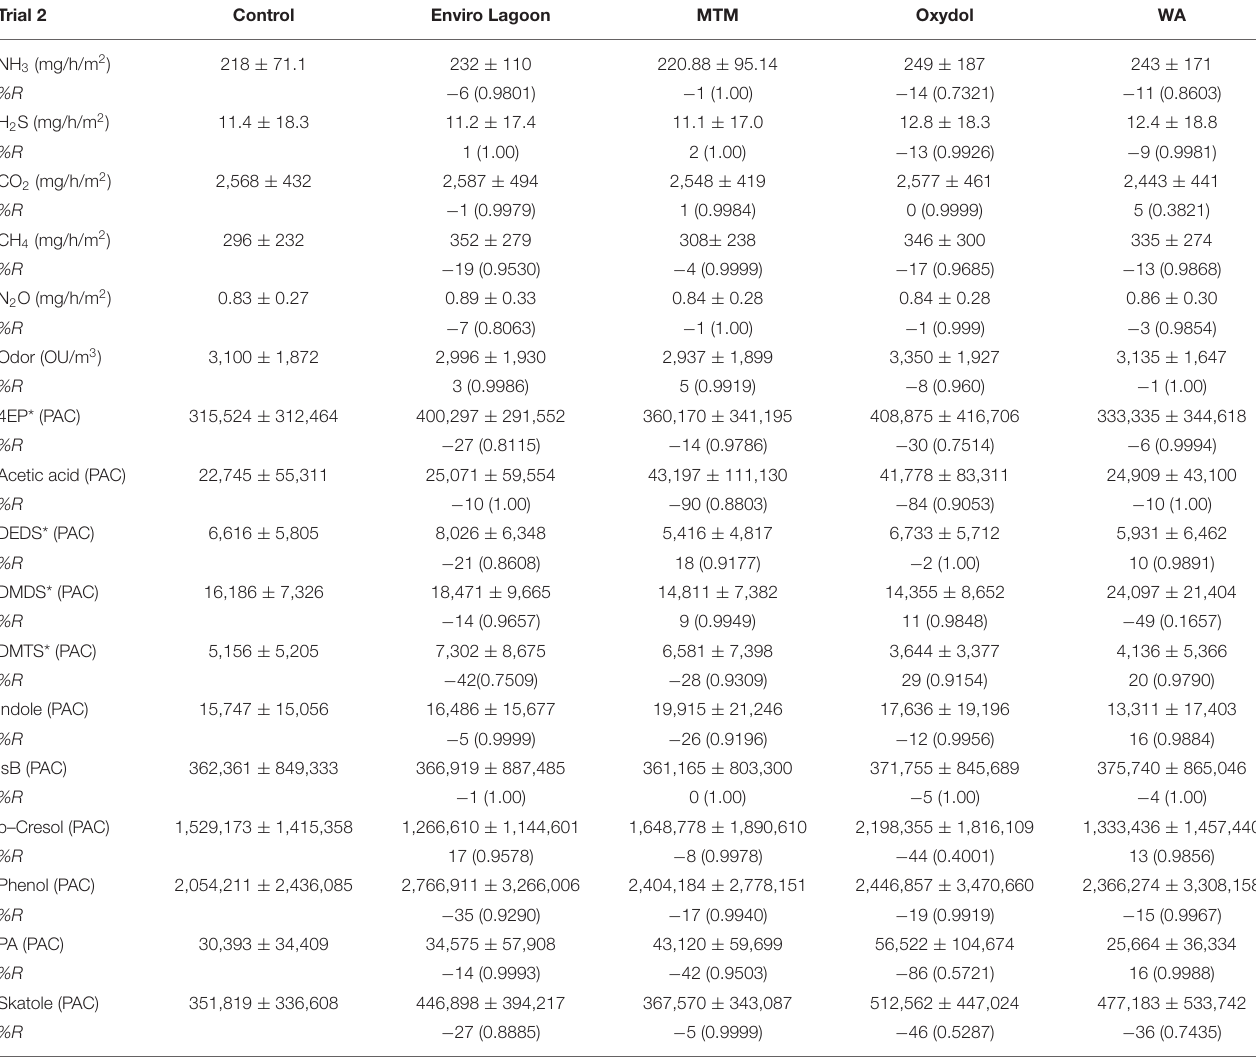
TABLE 4 | Trial 2-comparison of averaged gaseous emissions from three manure sources (farms) with their standard deviations. Trial